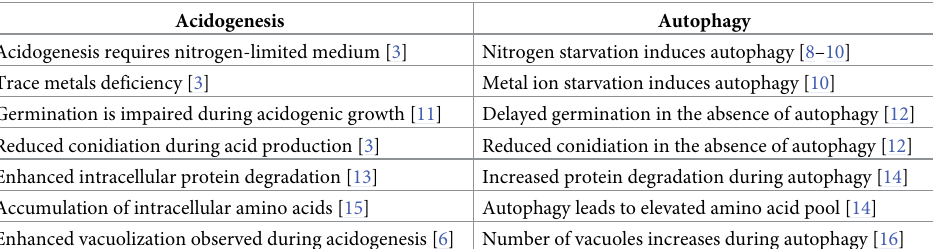
Table 1. Autophagy and acidogenesis–A